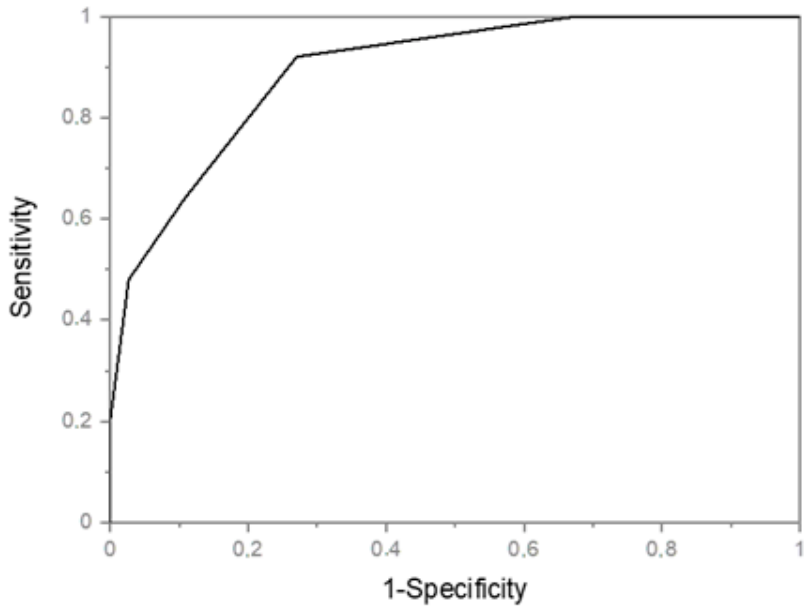
Figure 2. NS-IBD ROC Curve. IBD Nutritional Screening tool (NS-IBD); Receiver Operating Charac- teristic (ROC).